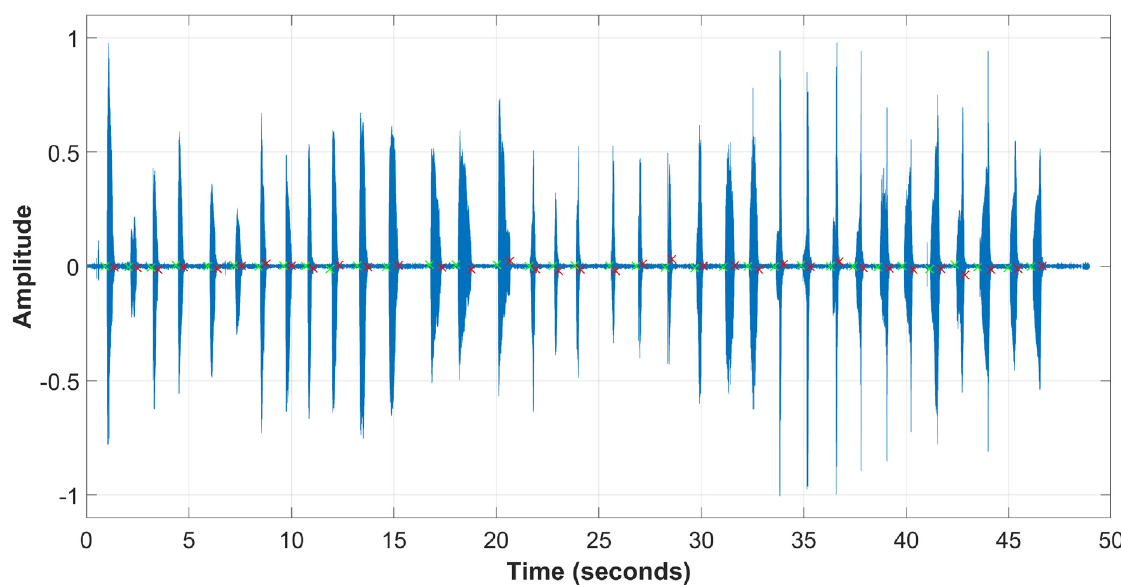
Fig 5. A data example of CUEB French Phoneme Database 1.0 (developed from S1 Audio). https://doi.org/10.1371/journal.pone.0257901.g005 mean power of the signal. The segmentation results are marked by using green and red crosses on the waveform plot, which correspond to the start and end edges, respectively. The size of the data set of this paper is therefore 35 phonemes × 6 sessions × 23 participants = 4830 sam- ples. Fig 6 shows the examples of the predictor vectors corresponding to the 35 French pho- nemes, which actually are the frequency spectrum of the utterance waveforms.